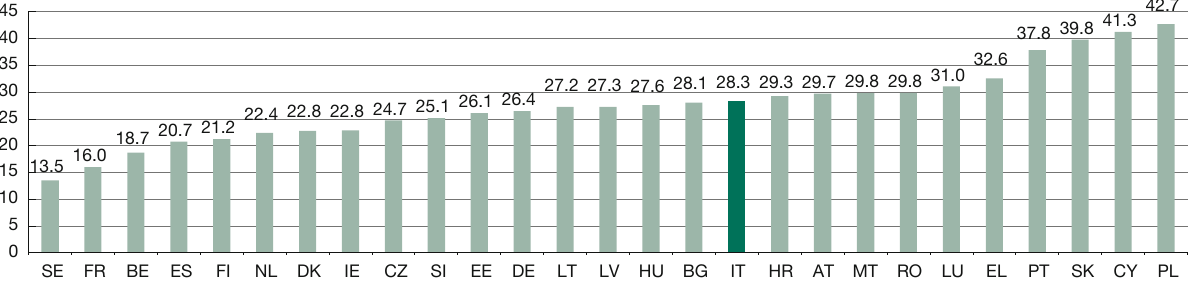
Change in the old-age dependency ratio 2016-2070, EU countries percentage